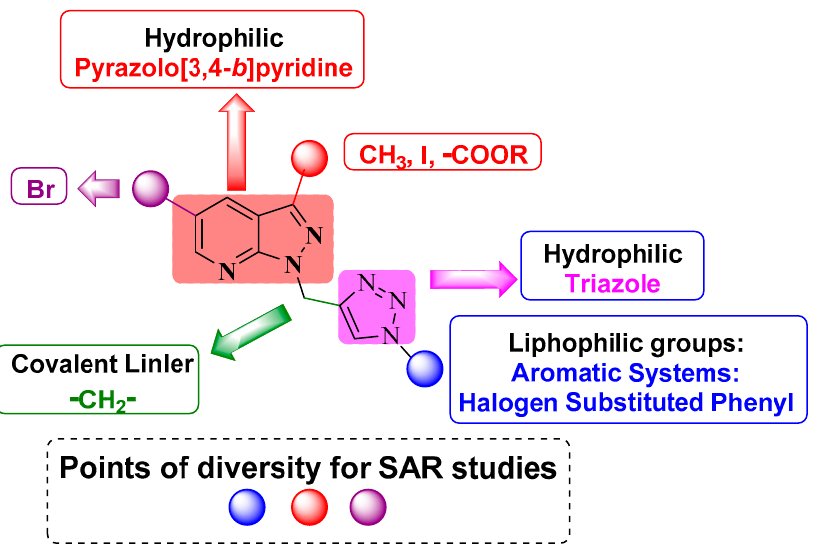
Figure 2. Design of the molecular hybrids of pyazolo[3,4- b ]pyridine and triazole.